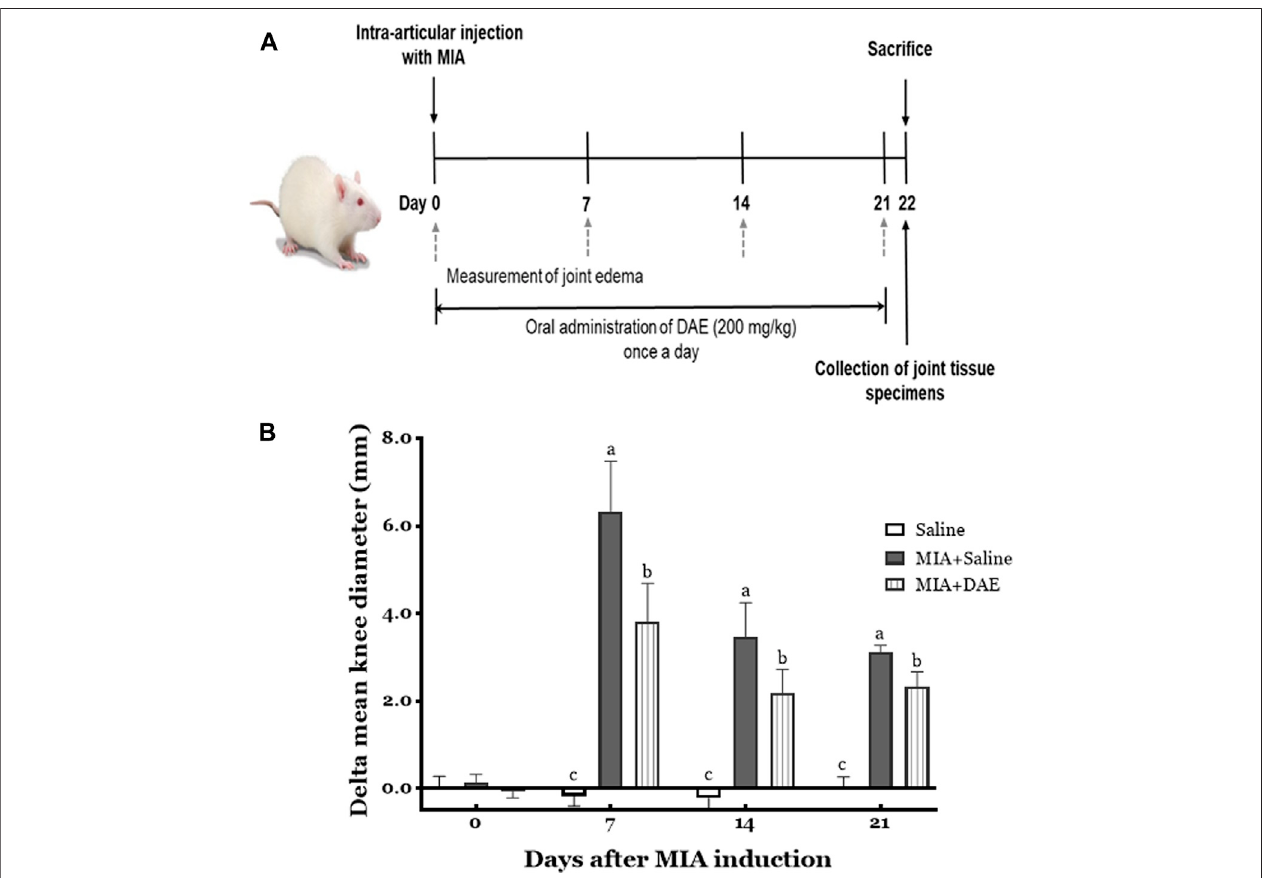
FIGURE 2 | Experimental scheme and effects of Dipsacus asperoides ethanolic extract (DAE) on knee diameter in monosodium iodoacetate- (MIA-) induced osteoarthritis in rats. (A) The experimental protocol used to induce OA by intra-articular injection with MIA and administration of DAE (200 mg/kg) every day for 21 days. (B) AfterMIAinjection,thekneediameterwasrecordedonceper weekfor21 days.Indexwascalculatedbysubtractingthevaluesoftheleftsidefromthoseoftheright. Dataareexpressed asmean ± SD ( n (cid:2) 8pergroup).Means(with lettersa, b,and c)weresigni fi cantlydifferentfromeach other,asdetermined bytwo-wayanalysis ofvariance(ANOVA)followedbyTukey ’ smultiplecomparisontest( p < 0.05).Saline,ratsgivensaline(vehicle);MIA+Saline,ratsinjectedwithMIAandgivensaline;MIA+ DAE, rats injected with MIA and given